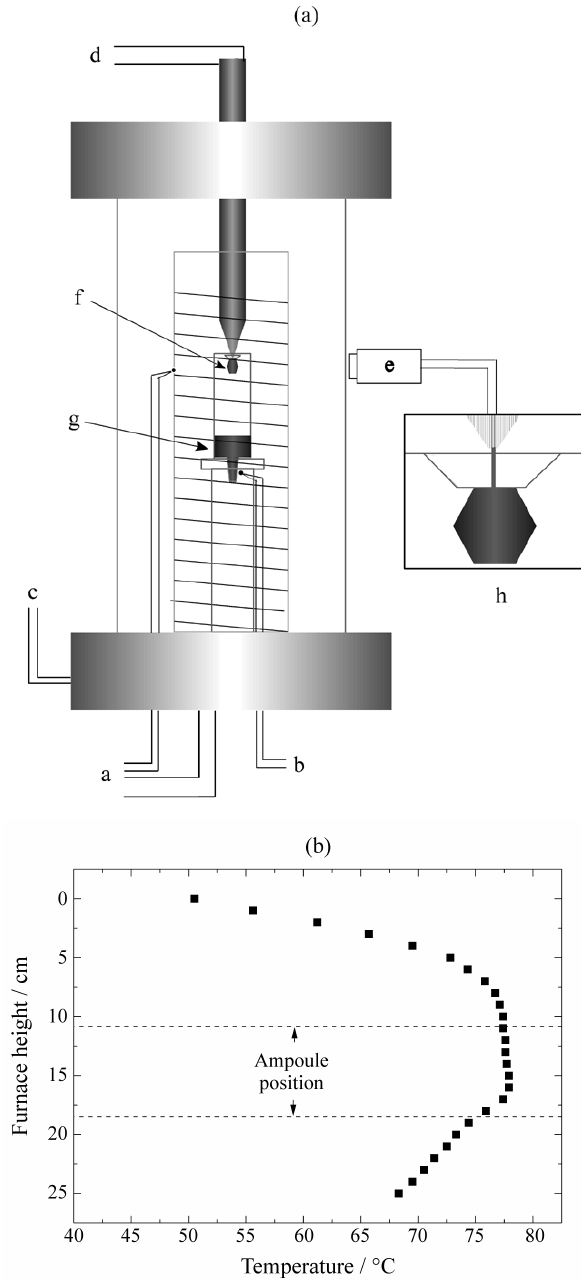
Figure 1. (A) Schematic drawing of the crystal growth furnace. a- temperature controller; b- source material temperature monitoring; c- vacuum system output; d- cold finger temperature controller; e- CCD video camera, f- HgI 2 single crystal, g- source material, h- video monitor. (B) Temperature profile of furnace without the ampoule